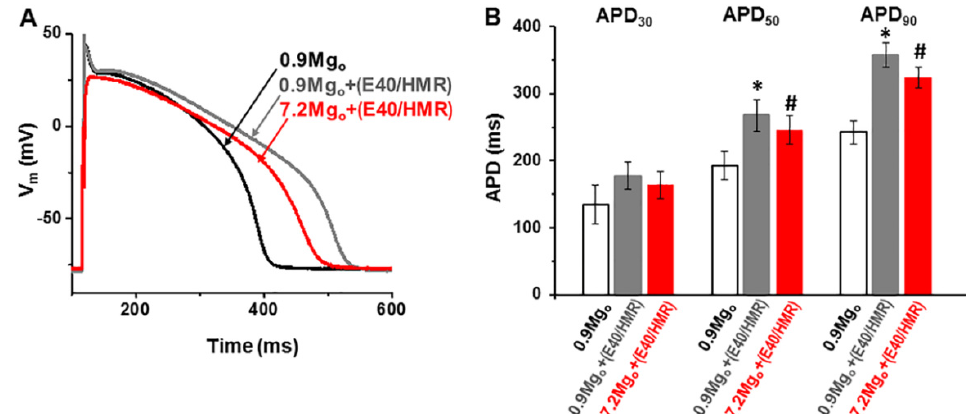
Figure 6. Effect of a partial I K block and high [Mg 2+ ] o on the action potential. ( A ) APs recorded at 36 ◦ C using K + -containing intra- and extracellular solutions under perforated patch conditions and initially superfused with control extracellular solutions containing 0.9-mM [Mg 2+ ]. A combination of HMR1556 (100 nM) and E4031 (500 nM) was then added in 0.9-mM [Mg 2+ ] o before applying 7.2-mM [Mg 2+ ] o together with the drugs. ( B ) Summary data of the AP duration (APD) at 30%, 50%, and 90% repolarization (APD 30 , APD 50 , and APD 90 , respectively) measured under the control conditions (unshaded column) in the presence of the I K inhibitors (grey column) and in the presence of the I K inhibitors but with the [Mg 2+ ] o raised to 7.2 mM (red column). * p < 0.05 for the presence vs. absence of the I K inhibitors (in 0.9-mM [Mg 2+ ] o ). # p < 0.05 for 7.2-mM vs 0.9-mM [Mg 2+ ] o in the presence of the I K inhibitors ( n = 4). Notice the shortening of the APD 50 and APD 90 by high [Mg 2+ ] o in the presence of the I K